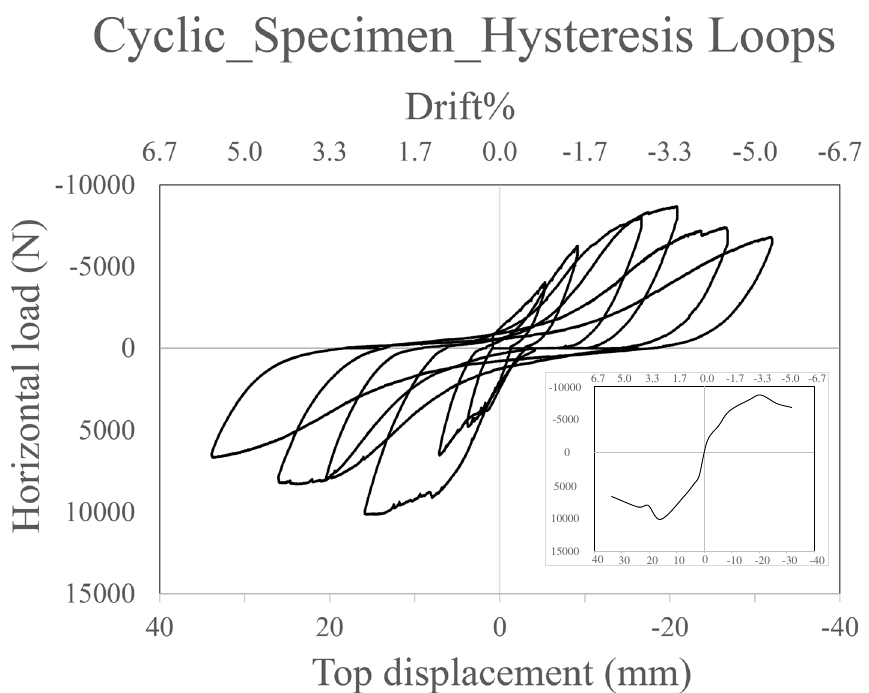
Fig. 13 Hysteresis loops of the cyclic